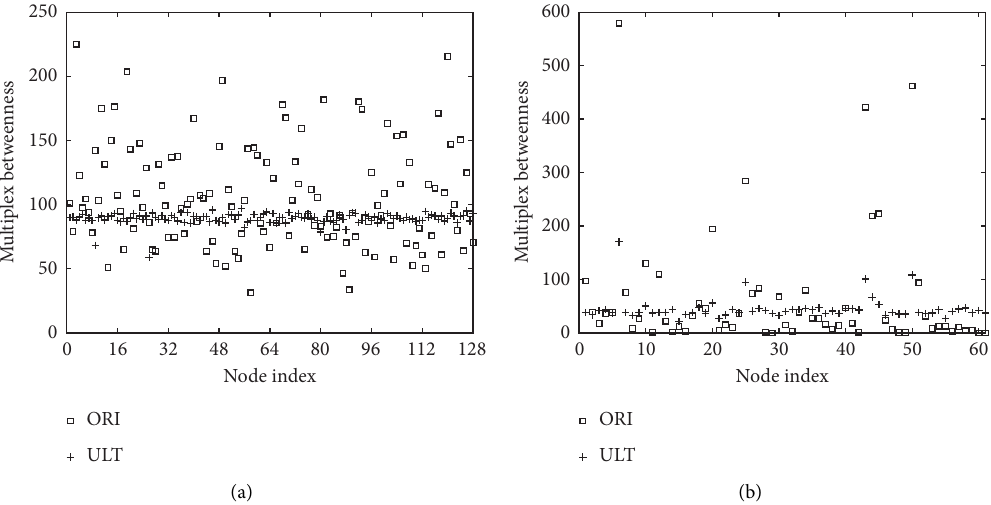
Figure 7: The multiplex betweenness of each node before and after applying MBP strategy. (a) The computer-generated multiplex network with (N) � 128, (m) � 4, < (k) > � 16, and (Z) in � 8 in layer 1 and (Z) in � 14 in layer 2. (b) The real CS-Aarhus multiplex network.